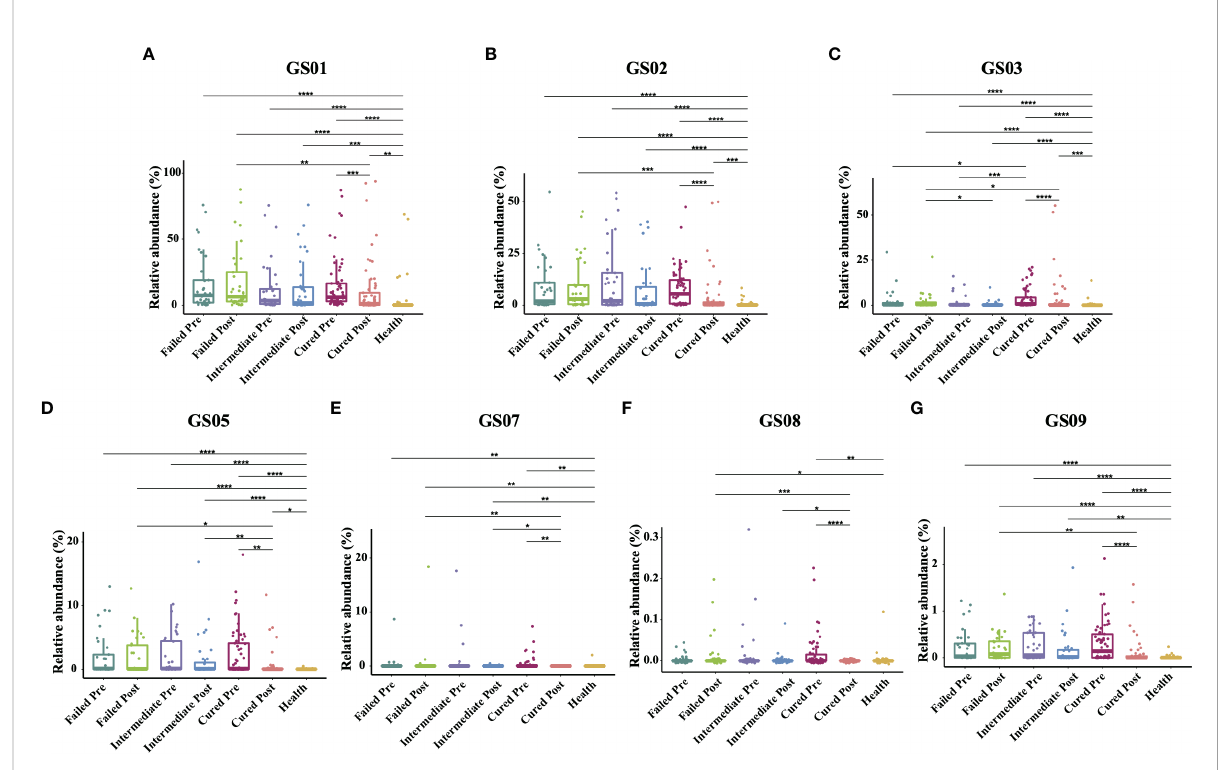
FIGURE 3 Comparison of Gardnerella genomospecies abundance in different groups. Intergroup comparison of the relative abundance of each Gardnerella genomospecies: GS01 (A) , GS02 (B) , GS03 (C) , GS05 (D) , GS07 (E) , GS08 (F) and GS09 (G) . Only statistically signi fi cant P value that has clinical meaning is marked in the graph. Signi fi cance is exhibited as: *: p<0.05; **: p<0.01; ***: p<0.001; ****: p<0.0001; Wilcoxon test for pairwise comparison between pre- and posttreatment and Kruskal-Wallis test for comparisons among different